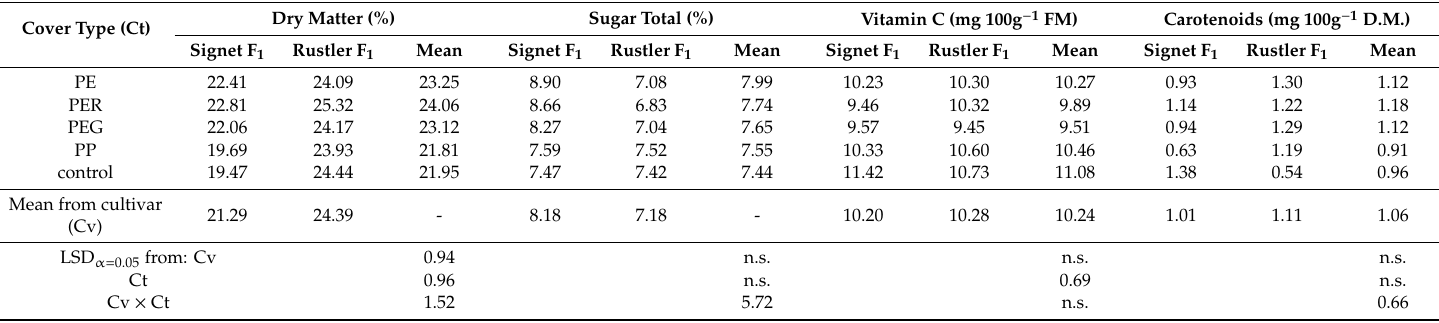
Table 7. Dry matter content, vitamin C, carotenoids and sugar total in sweet maize grain depending on varieties and type of cover. Mean from the years 2012–2014.